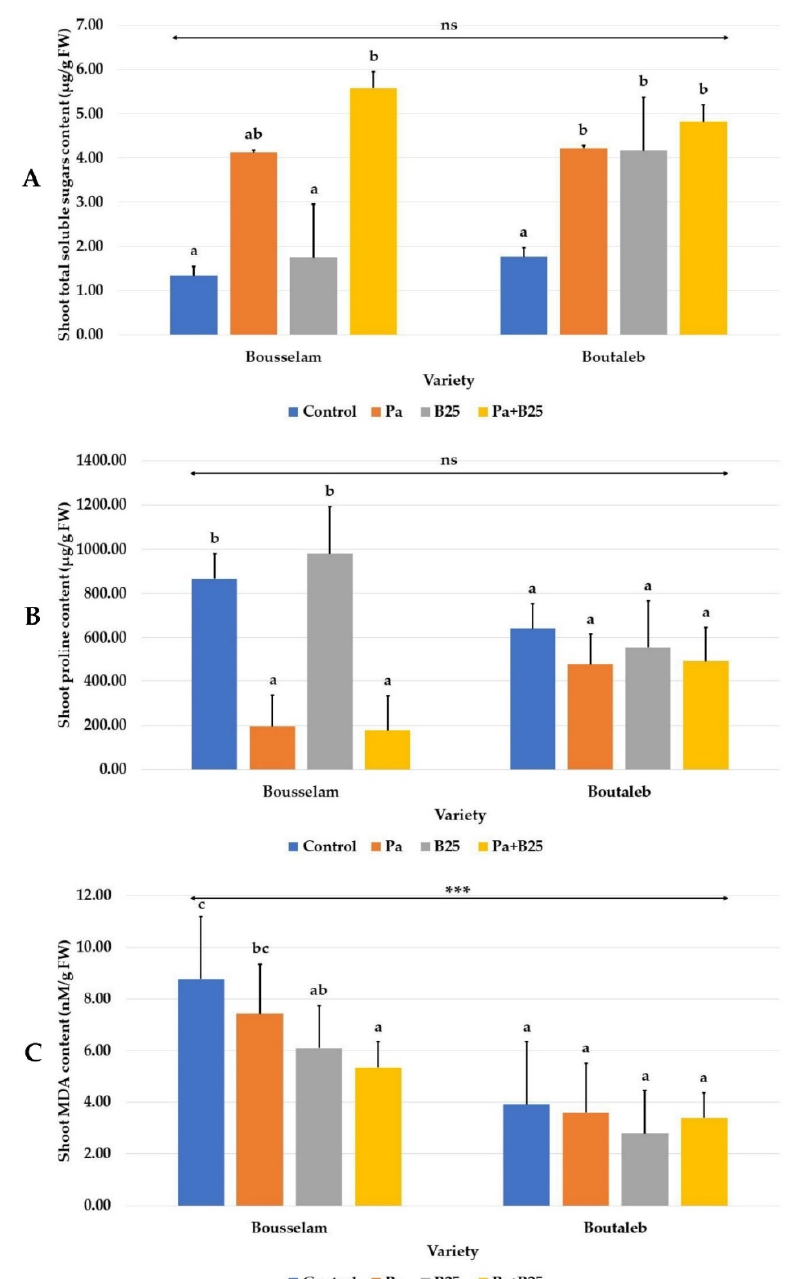
Figure 6. Effect of bacterial inoculation on ( A ) shoot total soluble sugars content (mg/g FW), ( B ) shoot proline content ( µ g/g FW), and ( C ) shoot malondialdehyde (MDA) content ( µ M/g FW) of wheat plants grown in sterile compost of Bousselam and Boutaleb varieties. The bar plots represent the mean ± standard error of three different experiments. IBM SPSS Statistics v.24 was used to perform statistical analysis, using a two-way ANOVA and Tukey’s multiple comparison post-test. Significant differences are displayed as: *** p < 0.001. ns: non-significant.